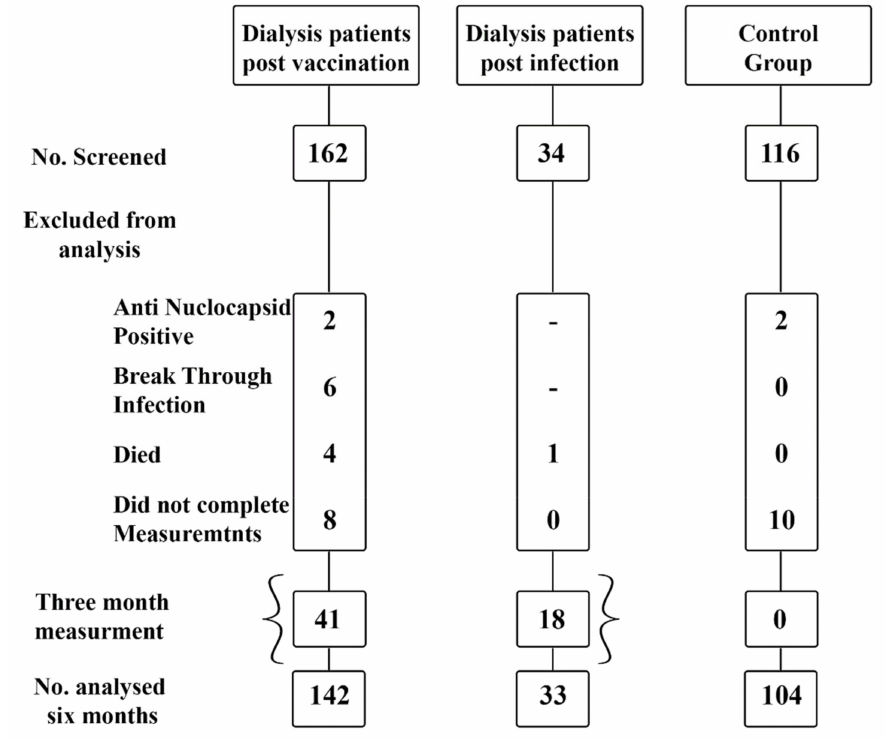
Figure 1. Flow Chart of the studied dialysis patients and healthy controls. The current observational study included 142 dialysis patients who completed 2 doses of the BNT162b2 mRNA SAR S-COV-2 vaccine at 1, 3 and 6 months and after the second vaccine dose were measured. We also measured SARS-COV-2 anti-spike antibody levels in dialysis patients who were infected with COVD-19 ( n = 33) as well as a control group of healthcare-employees ( n =